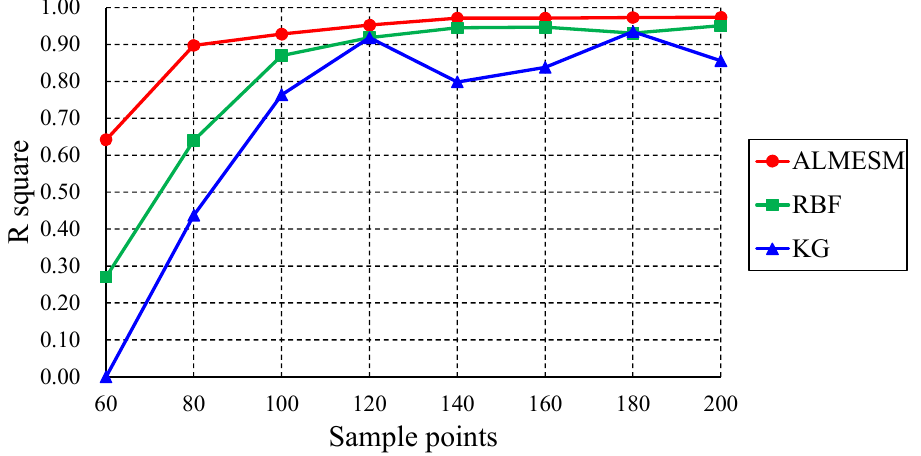
Figure 9. R-squared comparison of ALMESM, RBF, and KG under different number of sample points